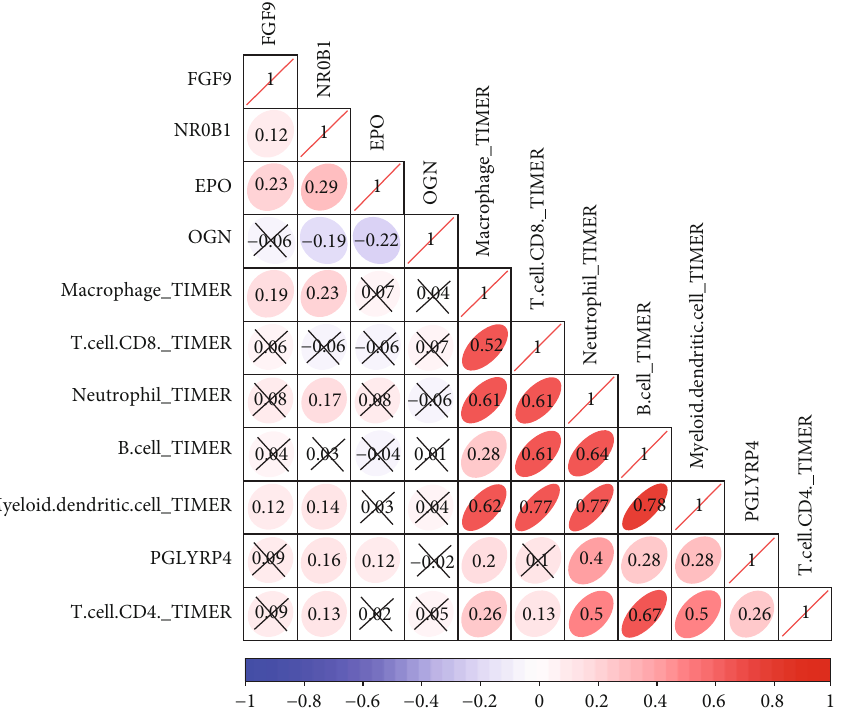
Figure 7: Immune cell in fi ltration analysis (TIMER). Red refers to positive correlation, blue refers to negative correlation, and the darker the color, the stronger the correlation. X represents that the correlation results between genes and immune cells are not signi fi